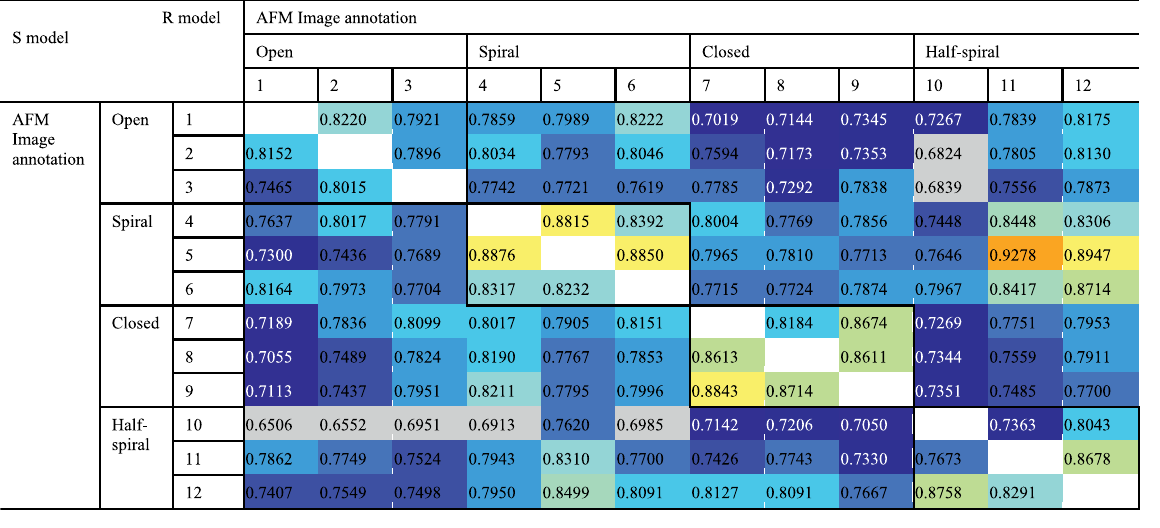
TABLE 2 | Cross-correlation (CC3D density ) between converged representative models for each AFM image derived from R and S models. The entries above the diagonal show similarity between reconstructedmodels derived from theR model, and thosebelowthe diagonal show similarity between reconstructed models derived from the S model.